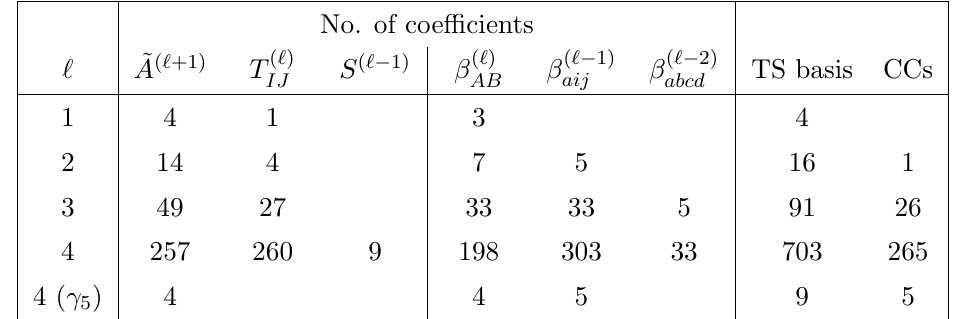
Table 1 . The table gives an overview of the number of coe(cid:14)cients appearing at each loop-order, ‘ , in Osborn’s equation. It also includes the number of TSs in the basis of the l.h.s. after